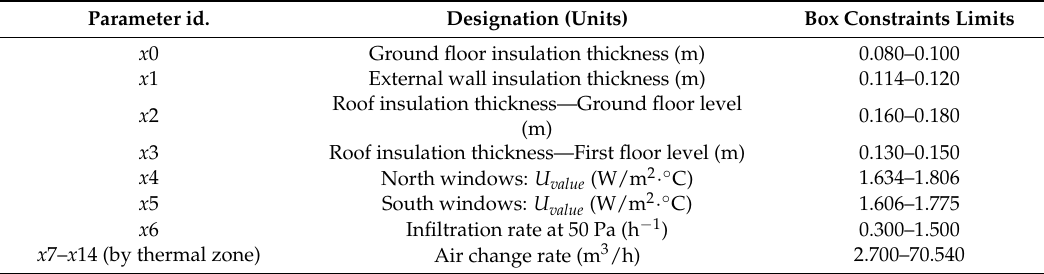
Table 3. Range of the unknown input parameters (continuous variables). Parameter